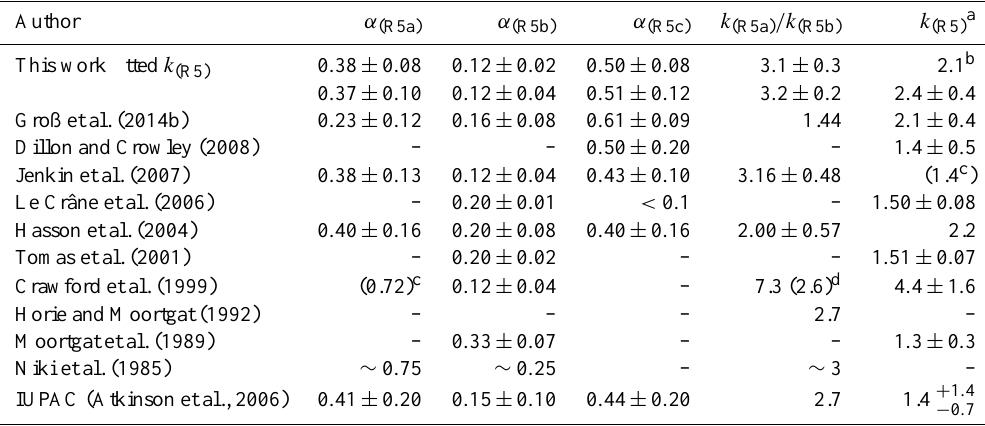
Table 4. Comparison of the results determined in this study with those present in the literature. Authors are referenced as they appear in the bibliography and tilde symbols indicate where a value was not measured directly. Data previous to Hasson et al. (2004) had not considered a third branching pathway ( α (R5c) ) but are included here to compare the ratio of k (R5a) and k (R5b) as well as the overall rate constant for CH 3 C(O)O 2 + HO 2 ( k (R5) )